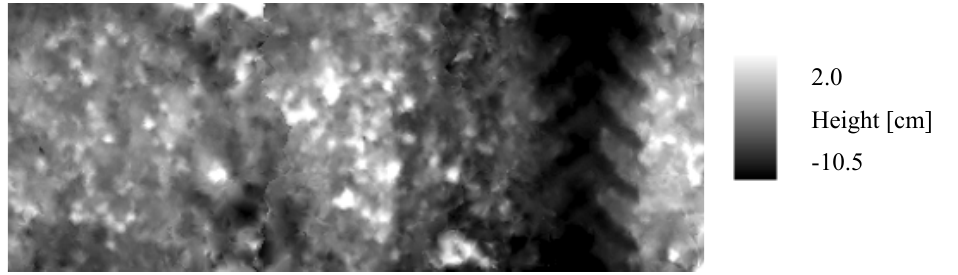
Figure 6. Digital elevation model of a roughness measurement performed in October 2009, clearly visible is the tractor track on the right. The heights are relative to the lower edge of the scaffold.